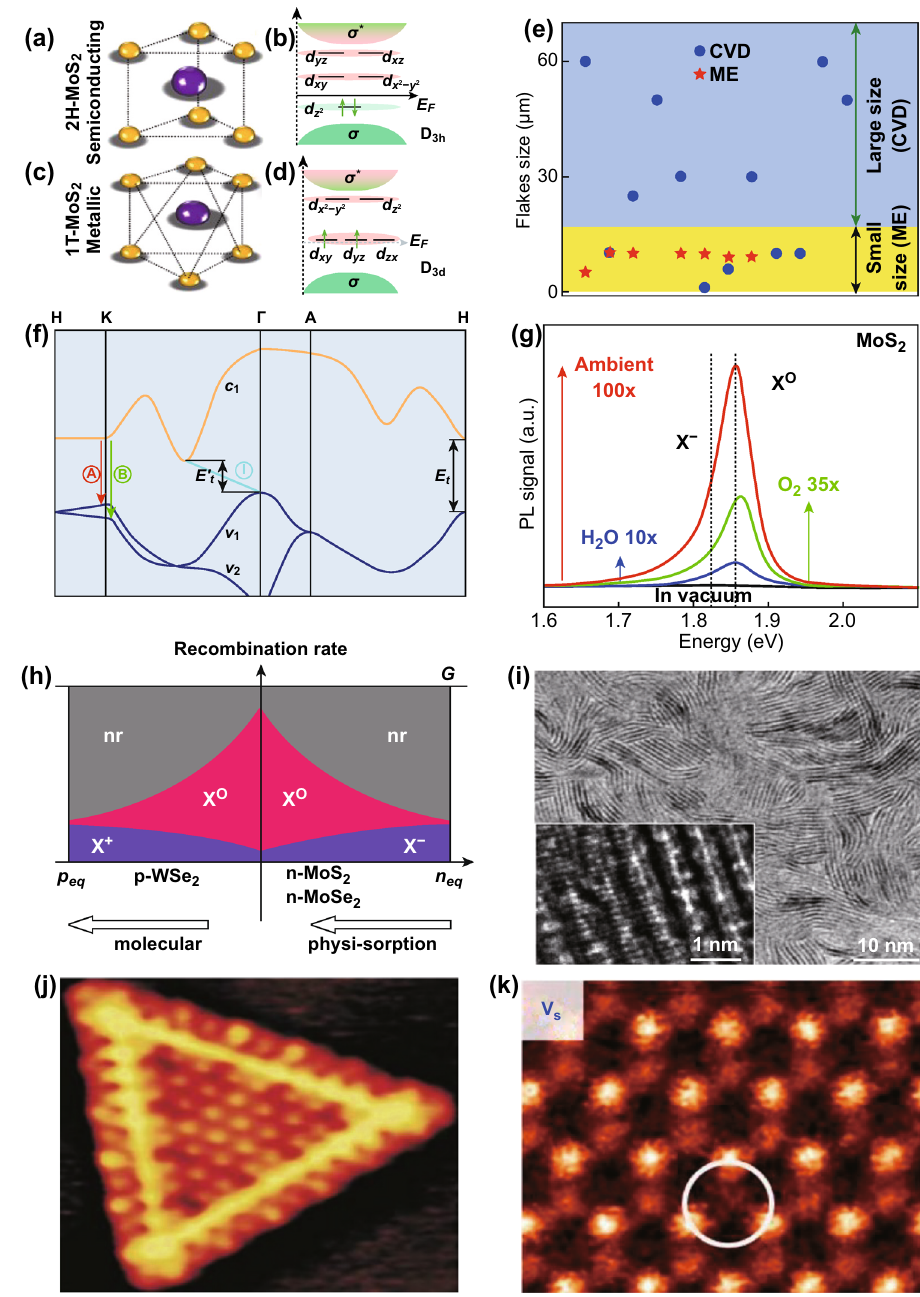
Fig. 4 a Schematic structure of 2H-MoS 2 . b d -orbital filling of the semiconducting 2H-MoS 2 . c Schematic structure of 1T-MoS 2 . d d -orbital filling of the semiconducting 1T-MoS 2 . e The reported domain size of individual monolayer MoS 2 flakes from the ME and CVD technique. CVD provides a larger flake size compared to the ME technique. The data of MoS 2 flakes size has been taken from Refs. [50, 107, 220, 222– 239]. f Band structure of MoS 2 . The ‘A’ and ‘B’ PL peaks are corresponding to the direct bandgap ( E g ) transition of MoS 2 . Reproduced with permission from Ref. [50]. Copyright (2010) American Physical Society. g Spectral change in PL due to exposure of O 2 alone, H 2 O alone and with both. O 2 and H 2 O incorporate p-type doping which contribute to a blue shift in the peaks. h Rate of recombination with neutral exciton and charge trion as a function of charge density in n-type MoS 2 and p-type MoSe 2 . Reproduced with permission from Ref. [219]. Copyright (2013) American Chemical Society. i TEM image of the as grown vertical aligned MoS 2 flakes. The edges have high catalytic activity than the basal plane and enhance the reactivity of the gas molecules. Reproduced with permission from Ref. [240]. Copyright (2013) American Chemi- cal Society. j STM image of the triangular MoS 2 flakes where yellow perimeters were showing the presence of the metallic states at the edges. Reproduced with permission from Ref. [241]. Copyright (2001) American Physical Society. k ADF images of monovacancy S intrinsic defects. Reproduced with permission from Ref. [242]. Copyright (2013) American Chemical